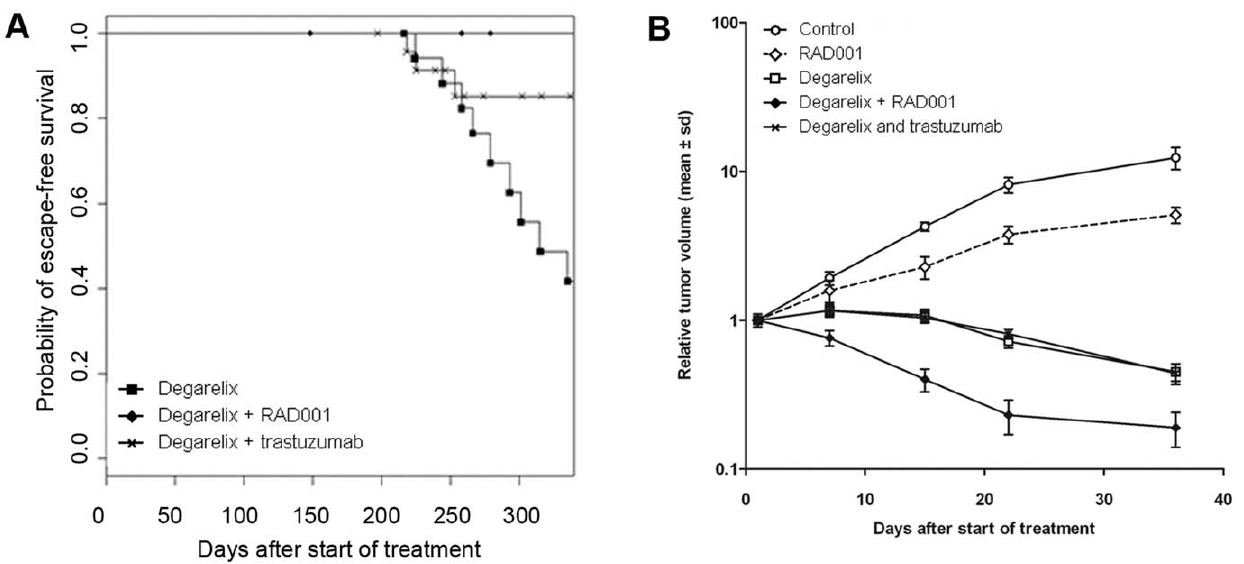
Figure 5. PAC120 xenograft tumor response to combination treatment of castration plus tyrosine kinase inhibitors shown as A ) escape-free survival (Kaplan-Meier analysis) where the median time to hormone escape after continuous treatment with degarelix (black square, full line) was 274 days and after combination of trastuzumab plus FE 200846 (cross, full line) was 351 days. B ) tumor growth curves as a function of time in the control group (white cercle, full line) and in groups receiving everolimus 2 mg/kg three times a week (white diamond shape, dotted line), degarelix 10 mg/kg monthly (white square, full line), trastuzumab plus degarelix (cross, full line) or everolimus plus degarelix (black diamond-shaped, full line).